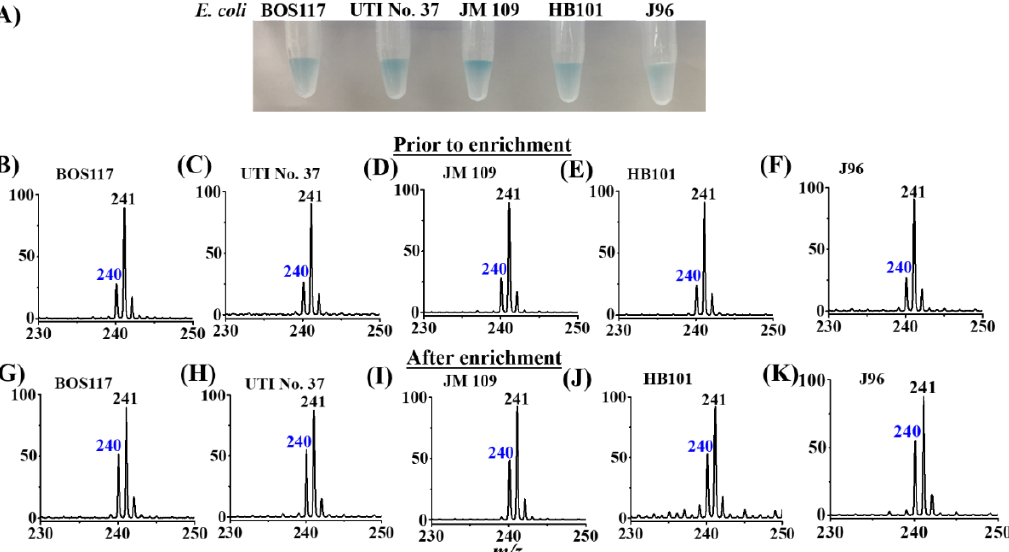
Figure 4. ( A ) Photograph of the samples (0.2 mL) containing E. coli BOS117, E. coli UTI No 37, E. coli JM109, E. coli HB101, and E. coli J96 with the concentrations of OD 600 of ~1 prepared in the ammonium acetate buffer (pH 4.5, 10 mM) obtained after reaction with H 2 O 2 (pH 4.5, 45 µL) and TMB (1 mg mL −1 , 5 µL) for 30 min. C-API mass spectra of the samples (0.2 mL) containing ( B ) E. coli BOS117, ( C ) E. coli UTI No 37, ( D ) E. coli JM109, ( E ) E. coli HB101, and ( F ) E. coli J96 with the concentrations of OD 600 of ~10 −6 prepared in the ammonium acetate buffer (pH 4.5, 10 mM) obtained after reaction with H 2 O 2 (pH 4.5, 2 µL) and TMB (1 mg mL −1 , 2 µL) for 30 min prior to enrichment. One droplet of the resultant samples (5 µL) were used for MS analysis. C-API mass spectra of the samples (3 mL) containing ( G ) E. coli BOS117, ( H ) E. coli UTI No 37, ( I ) E. coli JM109, ( J ) E. coli HB101, and ( K ) E. coli J96 with the concentrations of OD 600 of ~10 −6 prepared in the PBS buffer (10 mM, pH 7.5) obtained after enriched by the MALCY-probe, followed by releasing the bacteria trapped on the probe to ammonium acetate buffer (pH 4.5, 8 µL) for 15 min shaking, followed by addition of H 2 O 2 (100 mM,